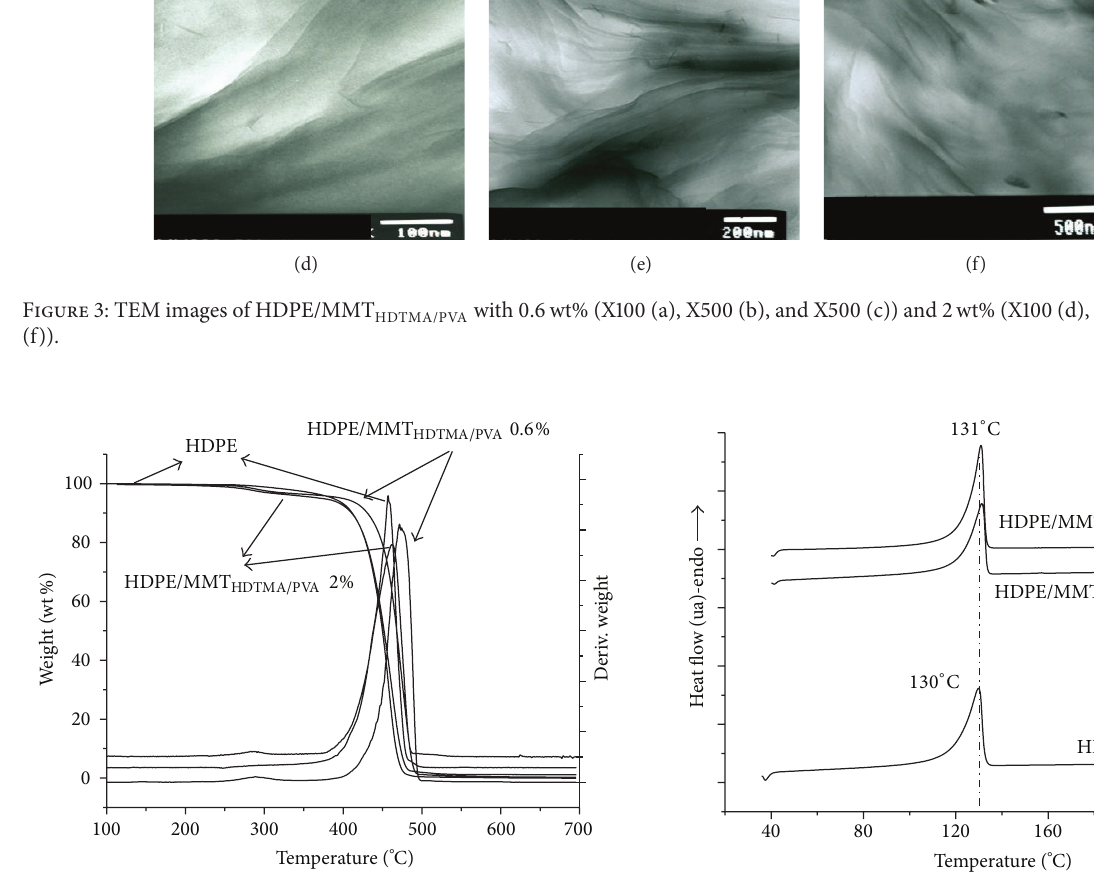
Figure 4: TG and DTG curves of HDPE, HDPE/MMT 0.6 wt%, and HDPE/MMT